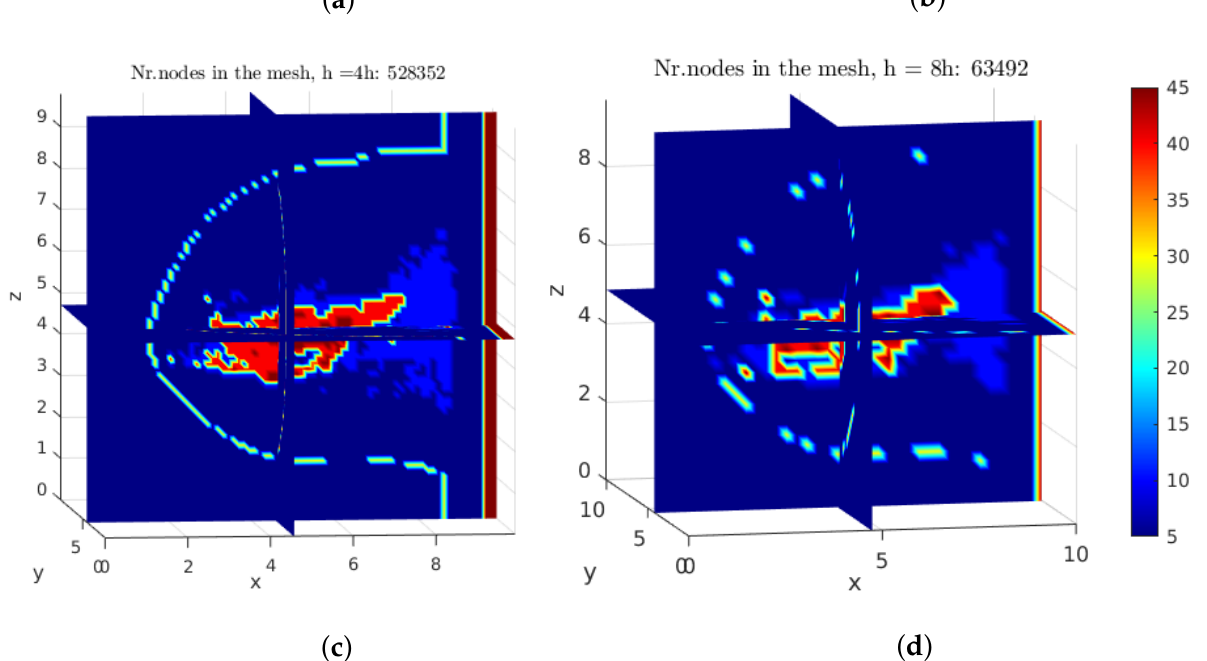
Figure 3. Spatial distribution of realistic ultrawideband dielectric properties of 3D breast phantom